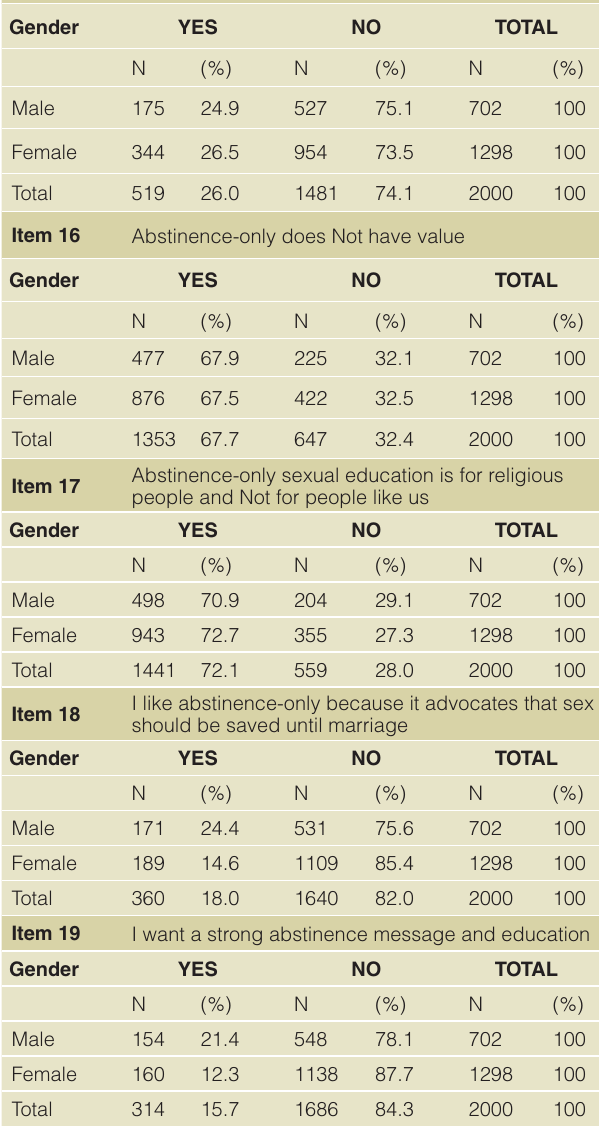
Table 9. Perspective of adolescents according to gender on the disadvantages of abstinence-only sexual education. Abstinence-only sexual education sometimes Item 8 encourages oral and anal sex alternatives Gender